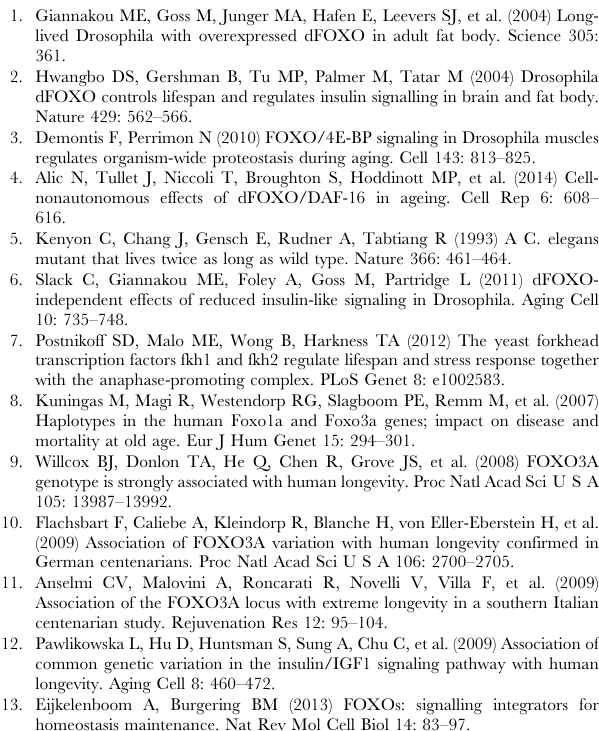
Figure S9 A Biological process GO categories differentially regulated (p , 10 2 10 ) in the fat body upon induction of dfoxo